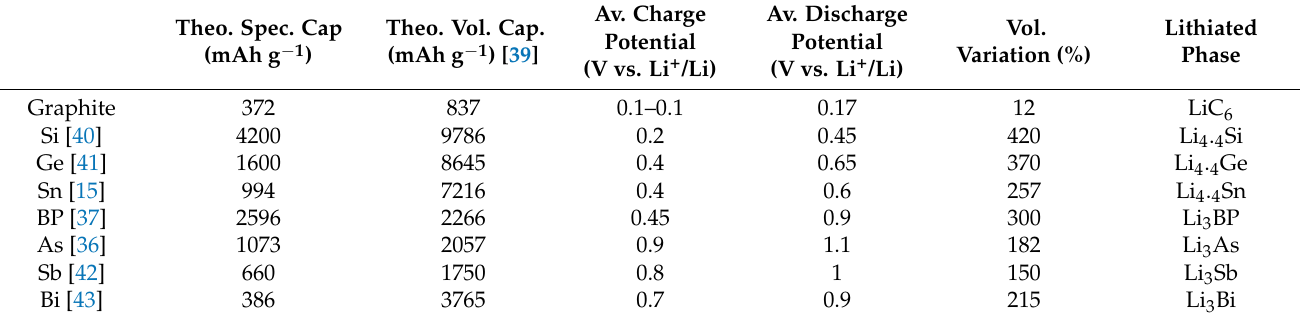
Table 1. Energy storage properties of alloy-based anodic materials for lithium-ion batteries. Theo. Spec.